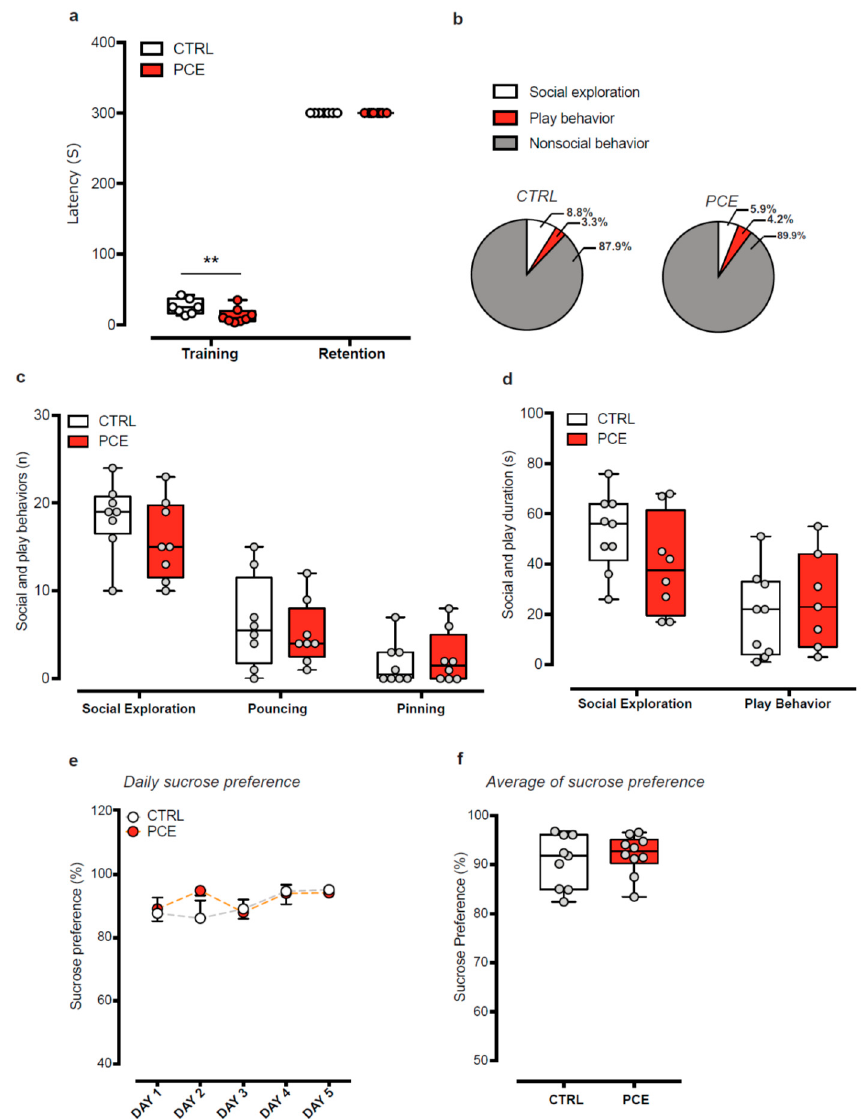
Figure 2. PCE impact on emotional memory, social interaction, and anhedonia-like behavior in female preadolescent rats.( a ) Passive avoidance (PA) latency (s) to enter in dark compartment during training (before foot shock) and retention (24 h after foot shock) sessions ( n = 7–8/group). ( b ) Pie chart representation of social (exploration and play behavior) and nonsocial behaviors exhibited during the social interaction test. No differences were found in terms of ( c ) number of social approaches, pouching and pinning and ( d ) total duration of time spent in social exploration and play behaviors ( n = 7–9/group). ( e ) Daily sucrose preference (%) during the 5 days of sucrose preference testing and ( f ) in the average sucrose preference. Data are represented as average ± s.e.m. (for sucrose preference curves) or as box-and-whisker plots with single values (min to max). **, p < 0.01.